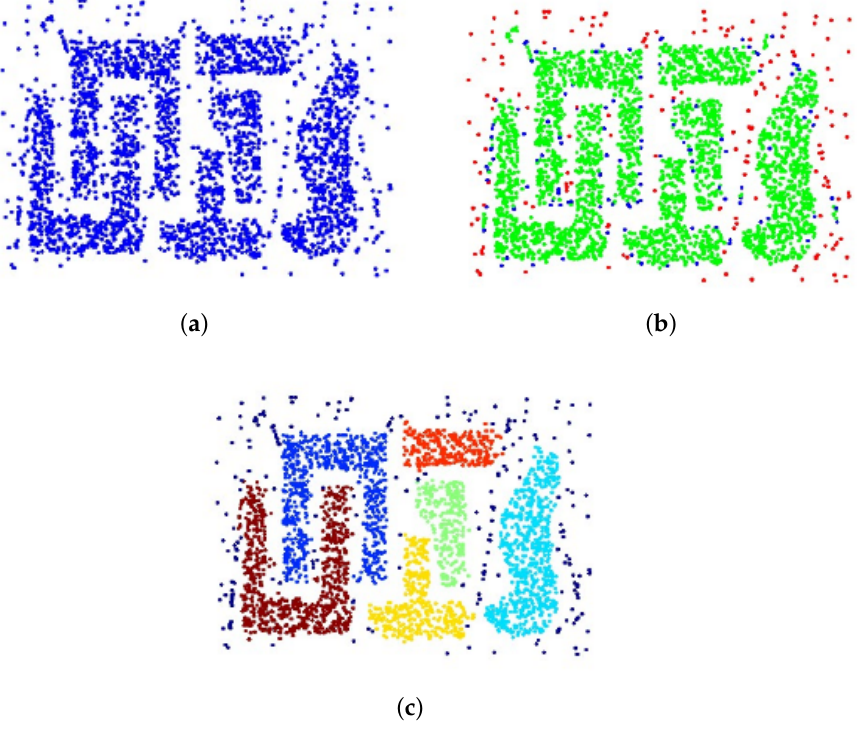
Figure 4. The explanation of the density-based spatial clustering of applications with noise (DBSCAN) algorithm. ( a ) is the original distribution of the dataset. ( b ) is the distribution of different type of the dataset: core (green) points, border (blue) points and noise (red) points. ( c ) is the cluster results with the DBSCAN algorithm applied to the